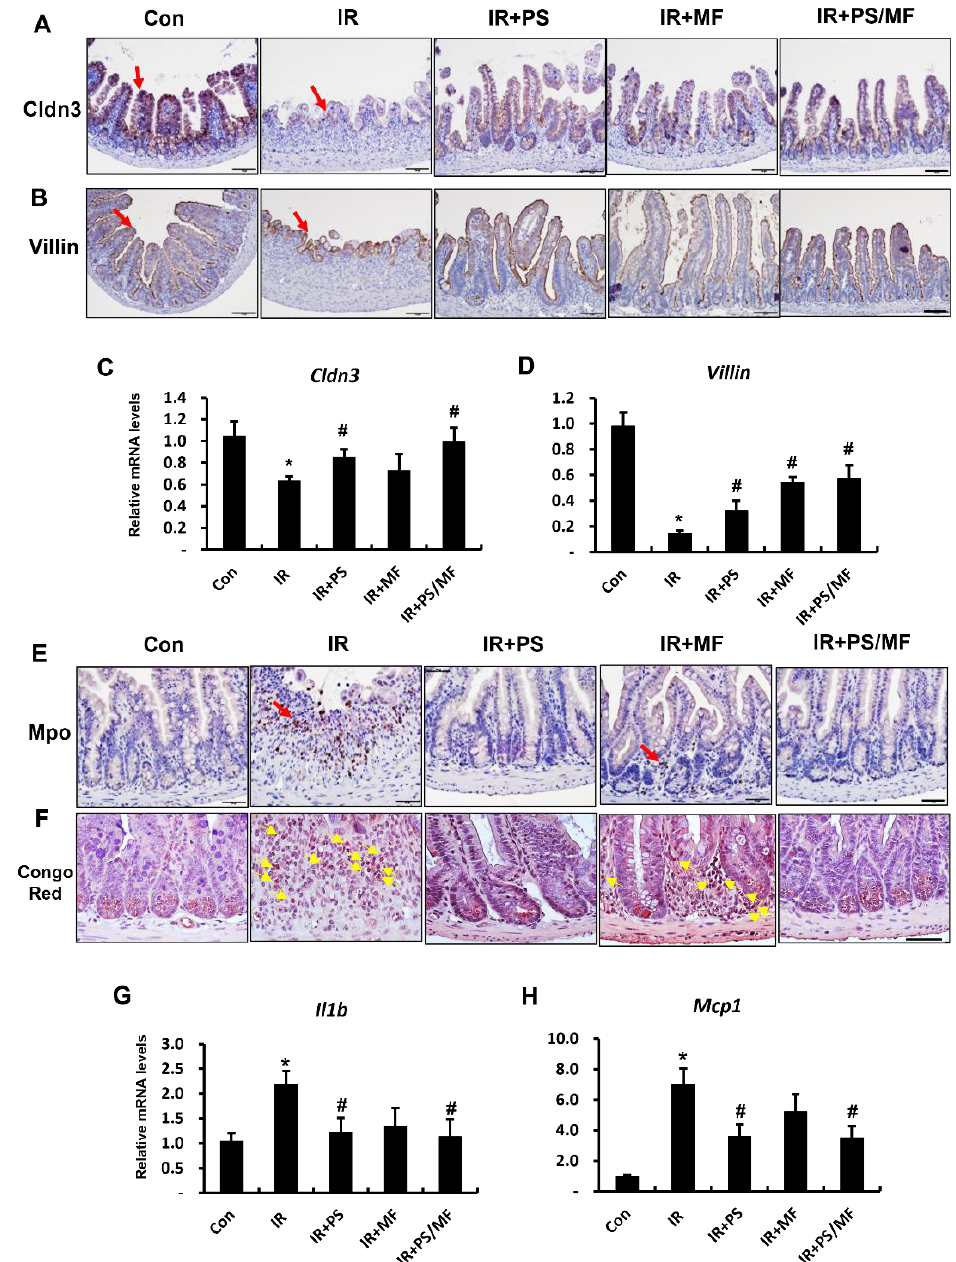
Figure 2. Effect of combined pravastatin and metformin treatment on epithelial barrier damage and inflammatory response in radiation-induced intestinal injury. Immunohistochemical analysis of ( A ) claudin 3 (Cldn3) and ( B ) villin in intestine tissue of control (Con), irradiated (IR), pravastatin-treated IR (IR + PS), metformin-treated IR (IR + MF), combined PS and MF-treated IR (IR + PS/MF) groups. Red arrows indicate Cldn3 and villin positive cells. Bar = 100 μm. mRNA levels of ( C ) Cldn3 and ( D ) villin of the intestine from Con, IR, IR + PS, IR + MF, IR + PS/MF groups. ( E ) Immunohistochemical analysis of myeloperoxidase (MPO) and ( F ) congo red stain for eosinophils. Red arrows indicate MPO positive cells. Yellow arrows indicate eosinophils. Bar = 50 μm. mRNA levels of ( G ) interleukin 1b (Il-1b) and ( H ) monocyte chemoattractant protein 1 (Mcp1) of the intestine from Con, IR, IR + PS, IR + MF, IR + PS/MF groups. Data are presented as the mean ± standard error of the mean; n = 5–6 mice per group. * p < 0.05 compared to the control; # p < 0.05 compared to the IR group.